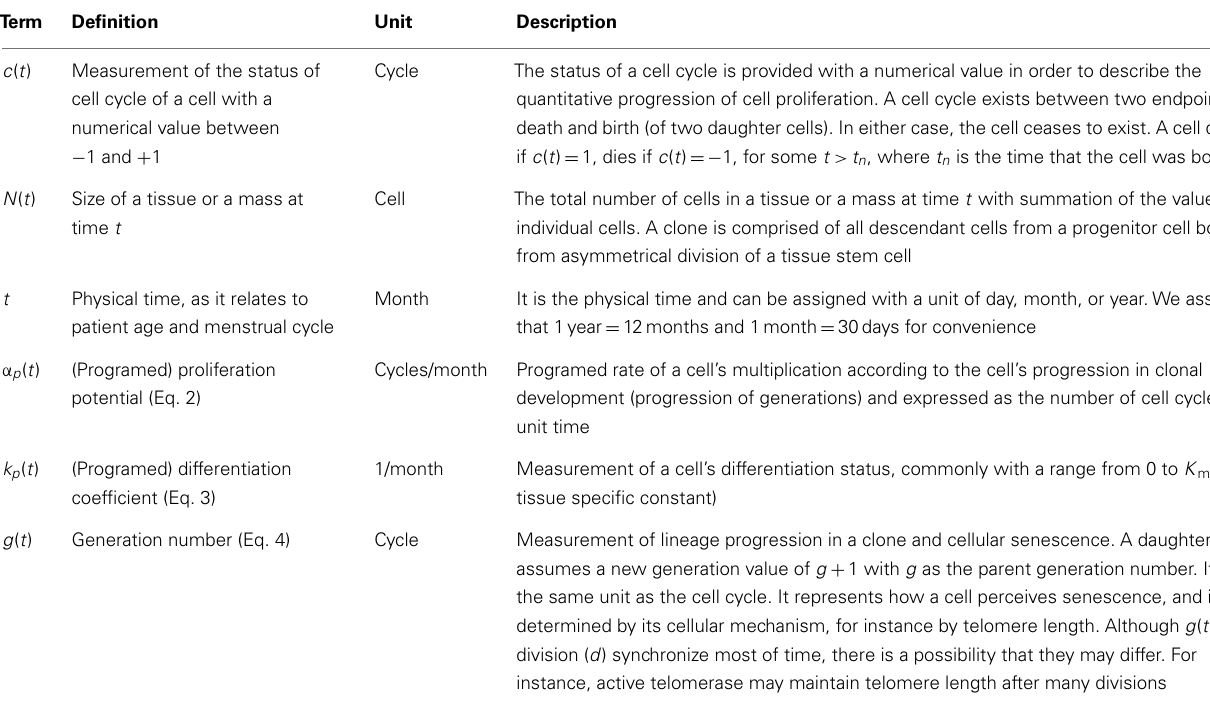
Table 1 |Terms for hypothetical cellular growth of a single cell.